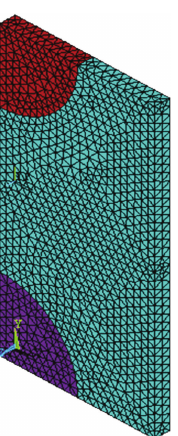
Figure 7: Geometry and FE mesh of a 3D model for case (i) and case (ii).